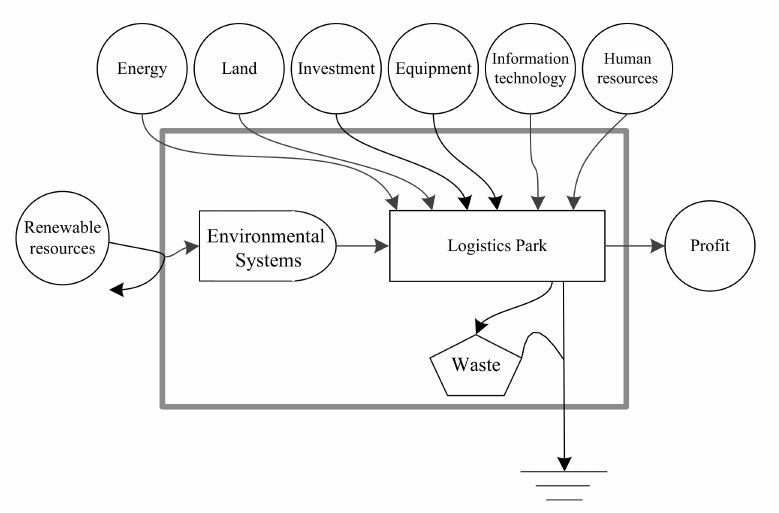
Figure 1. Emergy system diagram of a logistics